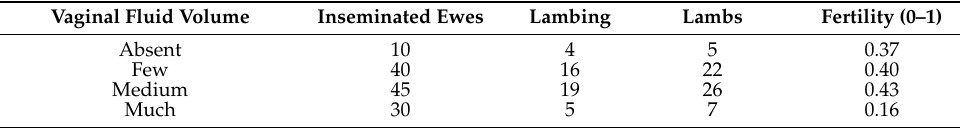
Table 7. Volume of vaginal fluids in the cervix and the fertility of organic Churra ewes in Spain. Vaginal Fluid